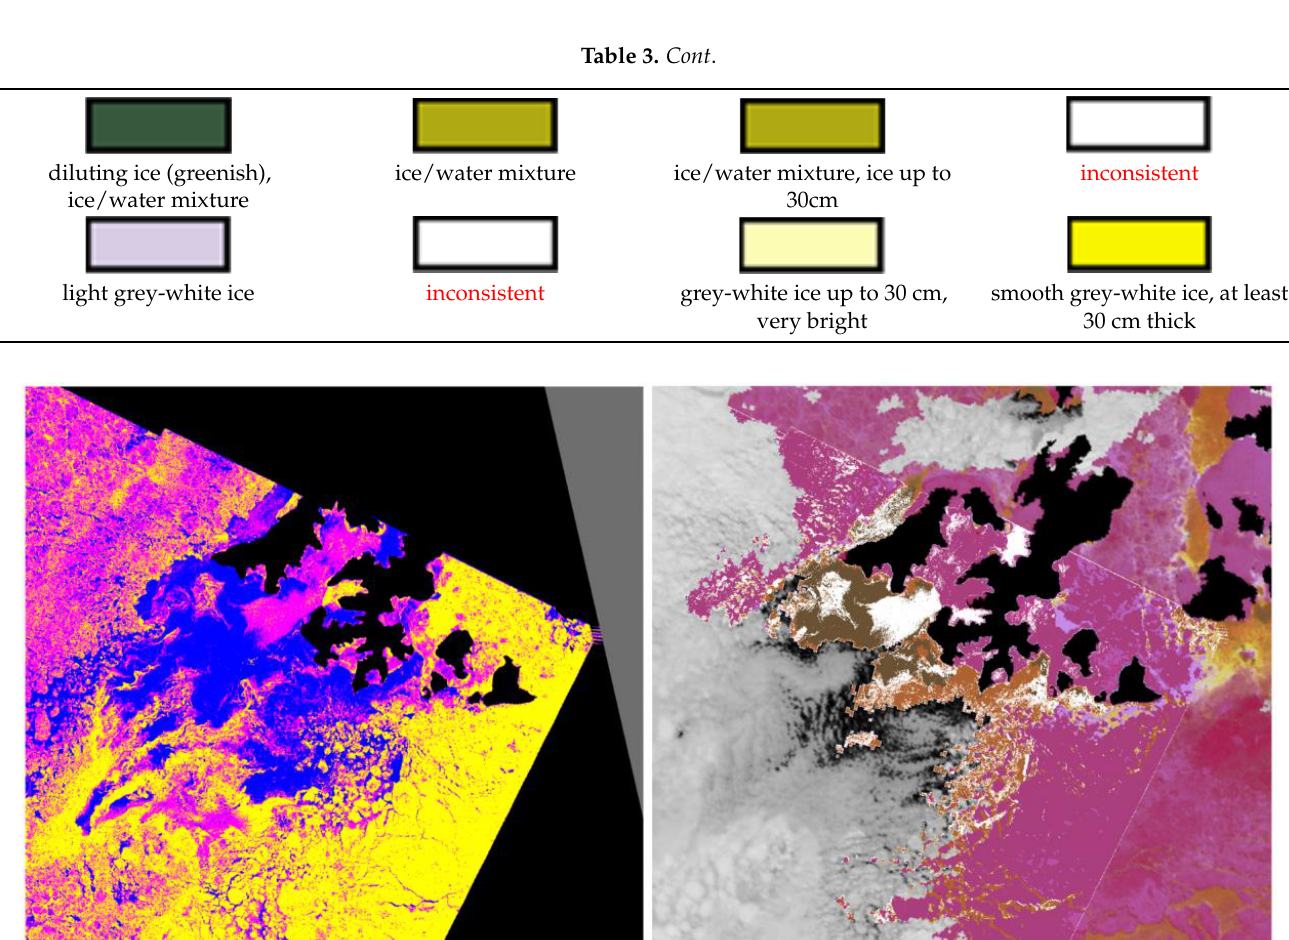
Figure 8. SAR ice classification ( left ) and combined SAR—optical ice classification computed according to the second described approach ( right ) for a test case on 12 May, 2017 in the vicinity of Franz Joseph Islands.